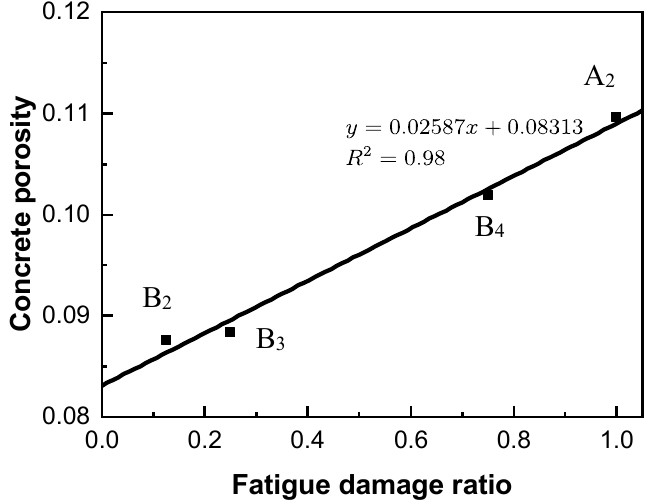
Figure 9. The porosity of the fatigue-damaged concrete